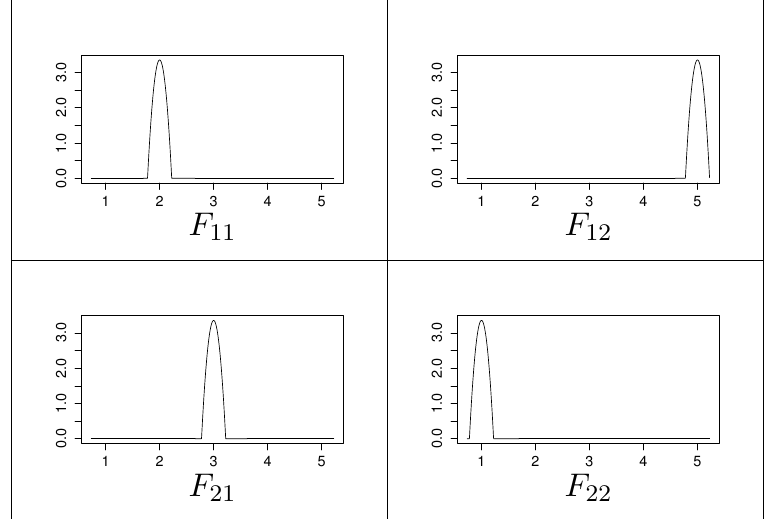
Figure 1. Distribution-valued game as a version of (14) with uncertainty around the expected payoffs (on the abscissa of each probability